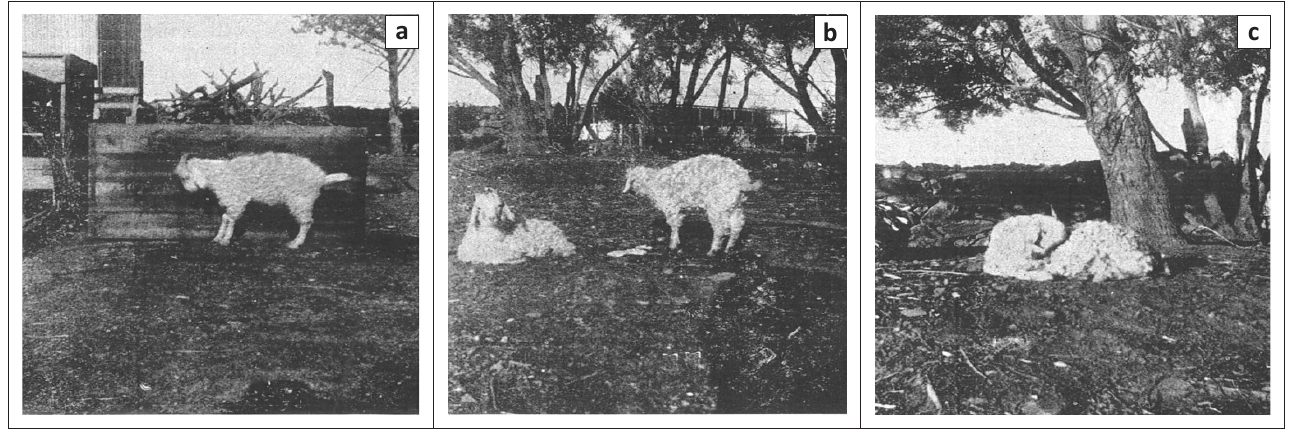
FIGURE 2: Photographs of goats suffering from krimpsiekte taken by Veterinary Surgeon Borthwick in 1898: (a) and (b) both represent the appearance of the goats when suffering from ‘nenta’ in the acute stage, whilst (c) represents the position they generally assume when lying down in the last stage of the disease, and in which they are usually found